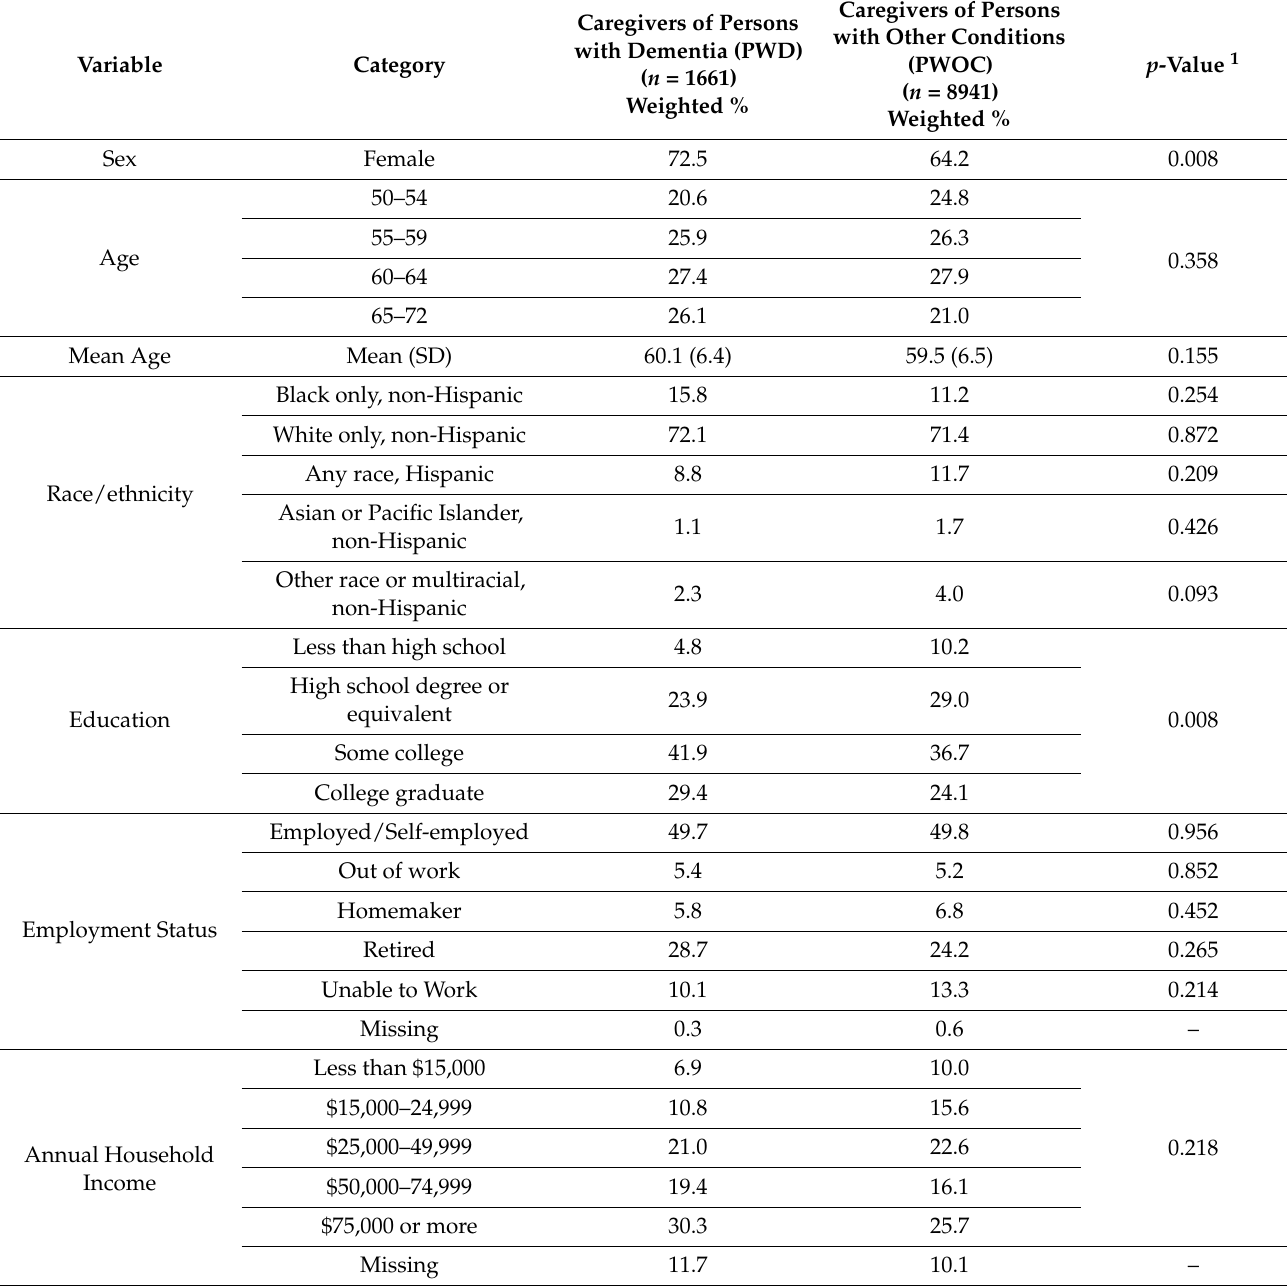
Table 1. Demographic and Health Characteristics of Baby Boomer Caregivers of Persons with Dementia (PWD) and Caregivers of Persons with Other Conditions (PWOC), Behavioral Risk Factor Surveillance System, 2015–2018.